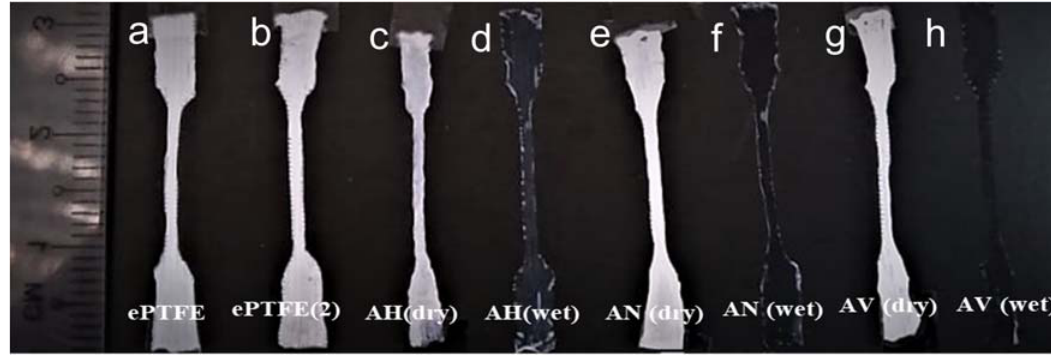
Figure 1: Physical appearance and lengths of samples: ( a ) unmodi fi ed ePTFE, ( b ) ePTFE ( 2 ) , ( c ) sample AH ( dry ) , ( d ) sample AH ( wet ) , ( e ) sample AN ( dry ) , ( f ) sample AN ( wet ) , ( g ) sample AV ( dry ) , and ( h ) sample AV ( wet )